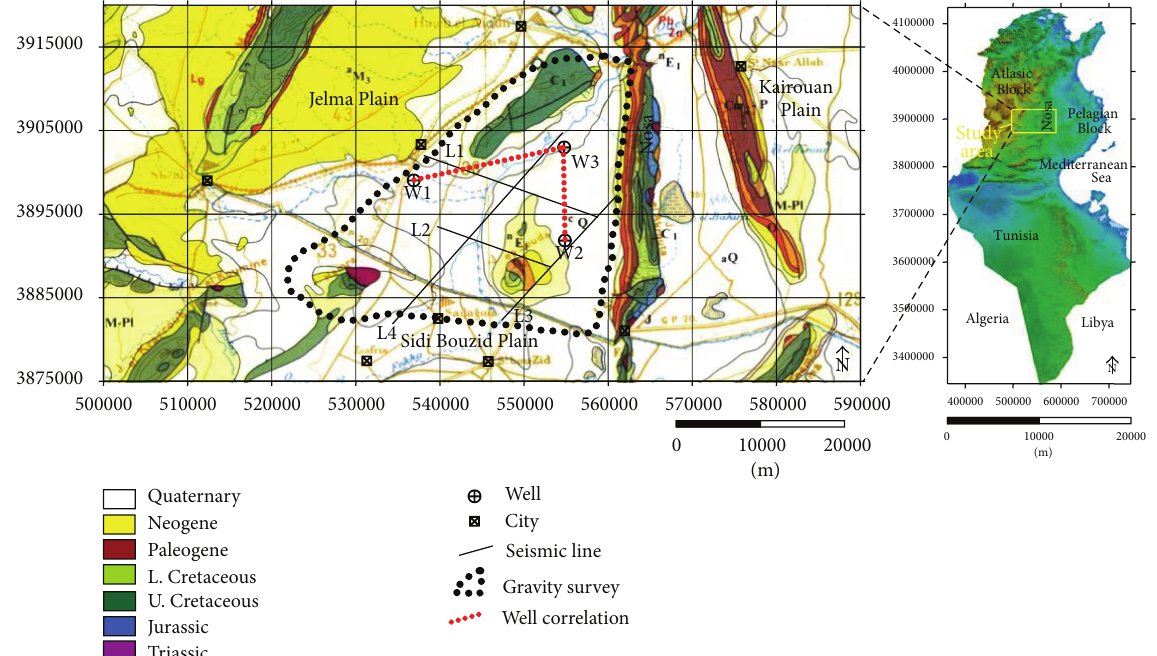
Figure 1: Location of the study area and the used geophysical data on the geological and structure map of central Tunisia [16].